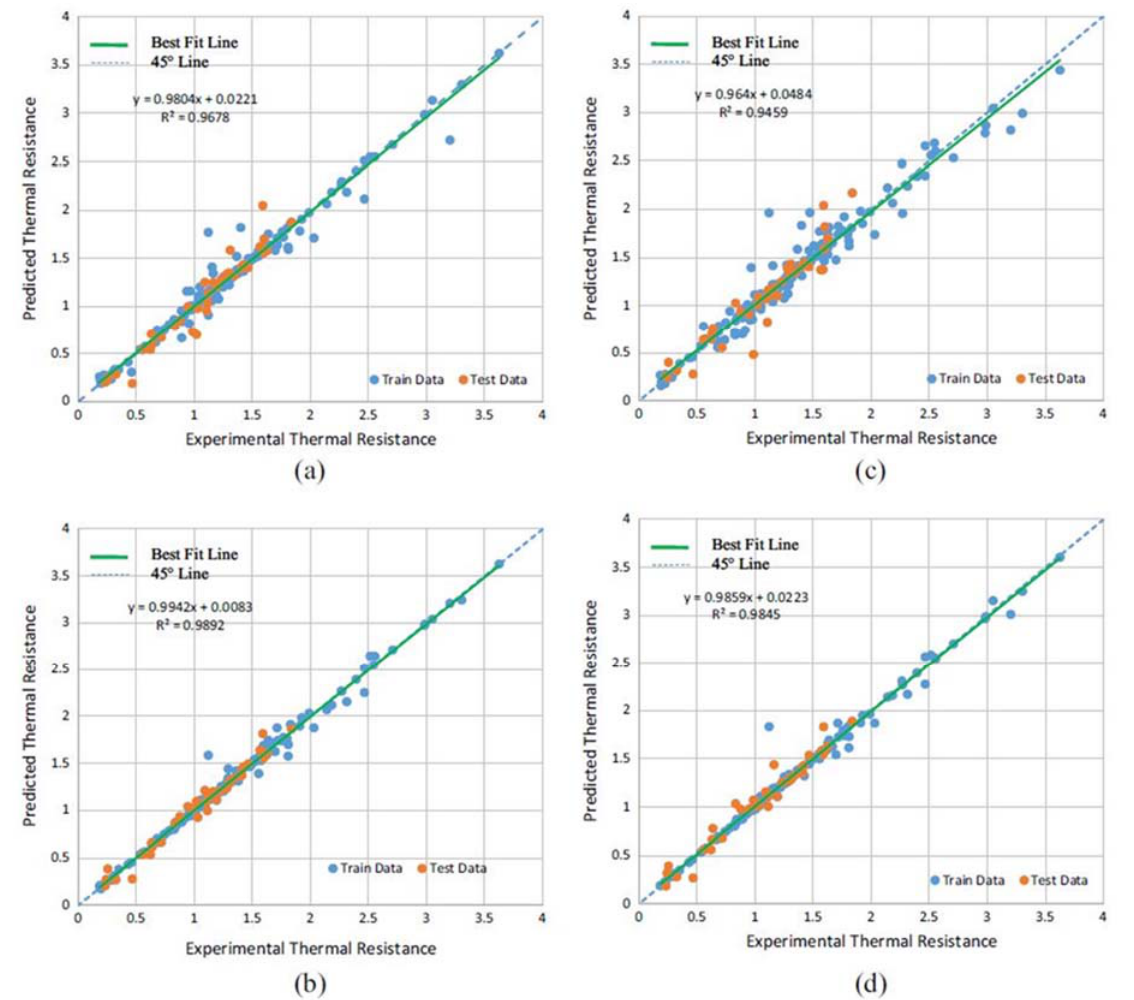
Figure 2. Predicted thermal resistance values by ( a ) MLP, ( b ) RBF, ( c ) ANFIS, and ( d ) LSSVM models compared to experimental data [59], with permission No. 5435490825671.